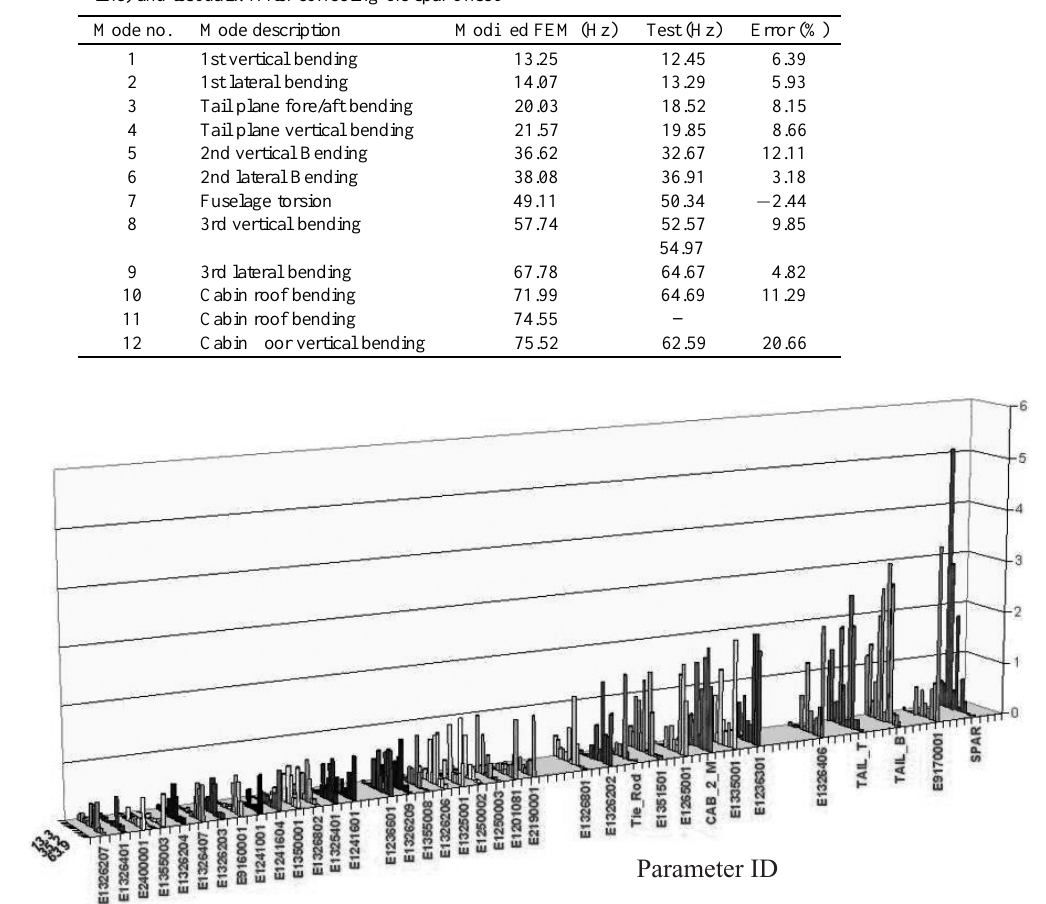
Fig. 5. Eigenvalue sensitivity to Young’s modulus: 36 most important